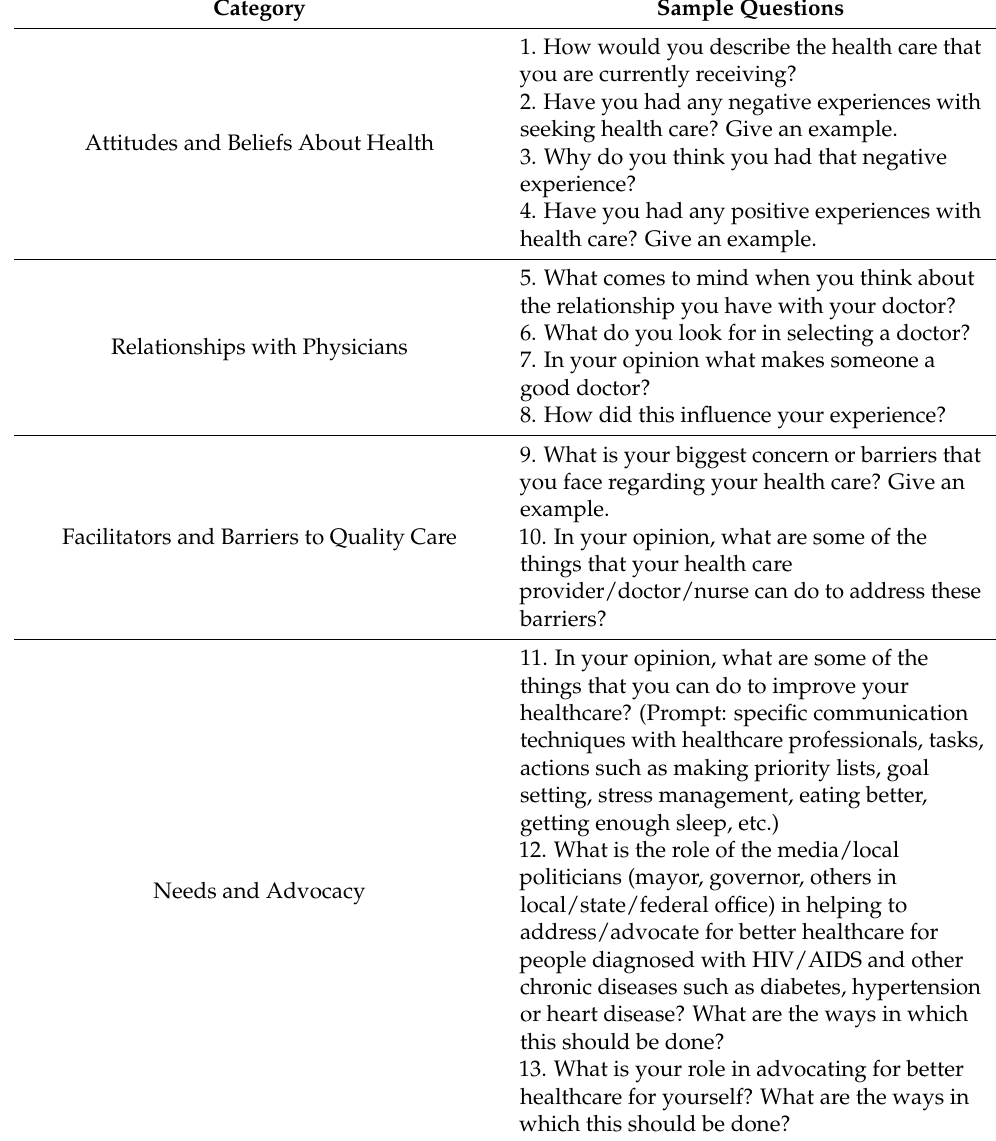
Table 1. Focus Group